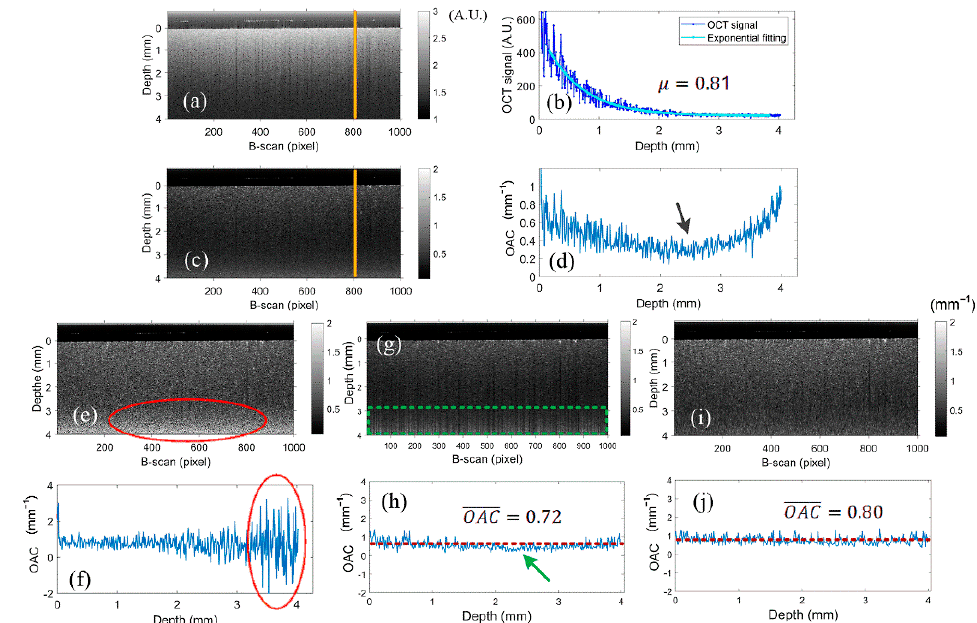
Figure 6. Phantom experiment results. ( a ) Logarithmic OCT B-scan image of the phantom. ( b ) Exponential fitting result of a typical A-scan (shown by the orange solid line in ( a )). ( c ) Original OAC image calculated from ( a ). ( d ) Original OAC curve at the position of the yellow line. ( e ) High-error OAC image. The fluctuations range of the tail OAC has increased significantly (Red oval). ( f ) High-error OAC curve. ( g ) OAC image calculated using Li et al.’s algorithm. Bright (dark) streak artifacts appear in deep regions of the image (shown in the green box). ( h ) The OAC curve obtained using Li et al.’s algorithm, with an average value of 0.72. There is a slight underestimation of the OAC in the middle region (green arrow). ( i ) The optimized OAC image. ( j ) The optimized OAC curve.